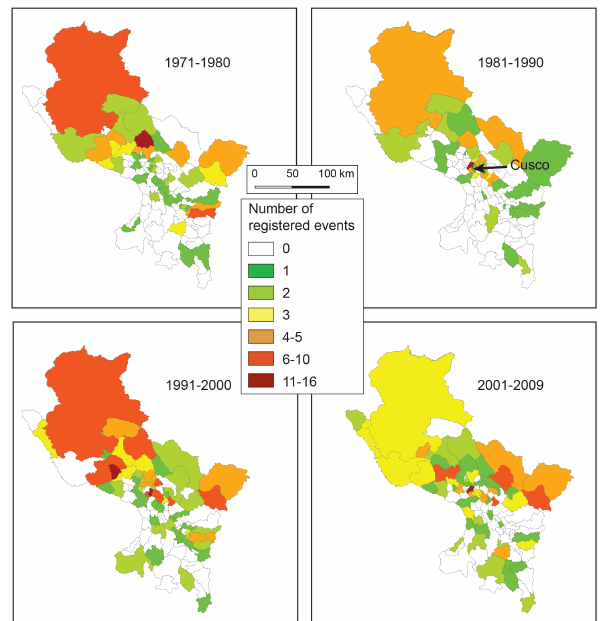
Figure 2. Spatiotemporal trends of disaster occurrence in the region of Cusco at the level of distritos over the period 1971 to 2009 (note that the last observation period only includes 9